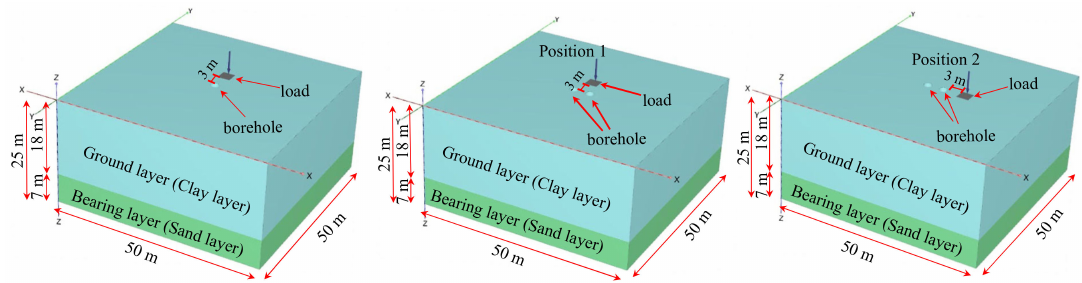
Figure 11. Analytical ground models for single and double boreholes under the loading condition.